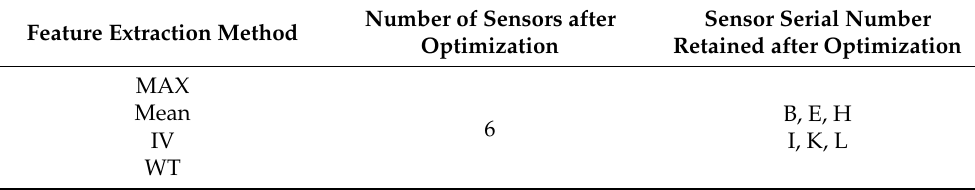
Figure 5. ( a ) The RF classifier’s average classification recognition rate of the four feature extraction methods without sensor array optimization. ( b ) The RF classifier’s average classification recognition rate of the four feature extraction methods after using RFECV as the sensor array optimization method. ( c ) The RF classifier’s average classification recognition rate of the four feature extraction methods after using RFFS as the sensor array optimization method. (The error bars represent the standard deviations of the recognition rates, and the calculation formula is 𝜎 = (cid:3493)((𝑥 (cid:2869) − 𝑥̅) (cid:2870) + (𝑥 (cid:2870) − 𝑥̅) (cid:2870) + ⋯+ (𝑥 (cid:3041) − 𝑥̅) (cid:2870) ) 𝑛⁄ , where 𝜎 represents the standard deviation, 𝑥 (cid:2869) , 𝑥 (cid:2870) ,…, 𝑥 (cid:3041) represent recognition rates, 𝑥̅ represents the average recognition rate, 𝑛 is the number of recognition rates. In this paper, we used 3-fold cross validation 100 times, so the value of 𝑛 is 300.) Table 3. The sensor array optimization results of RFECV based on RF.